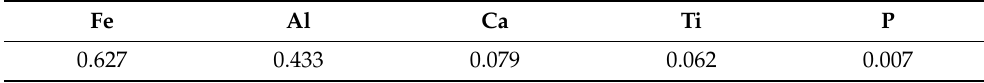
Table 1. Content of typical impurity elements in silicon samples, wt%.